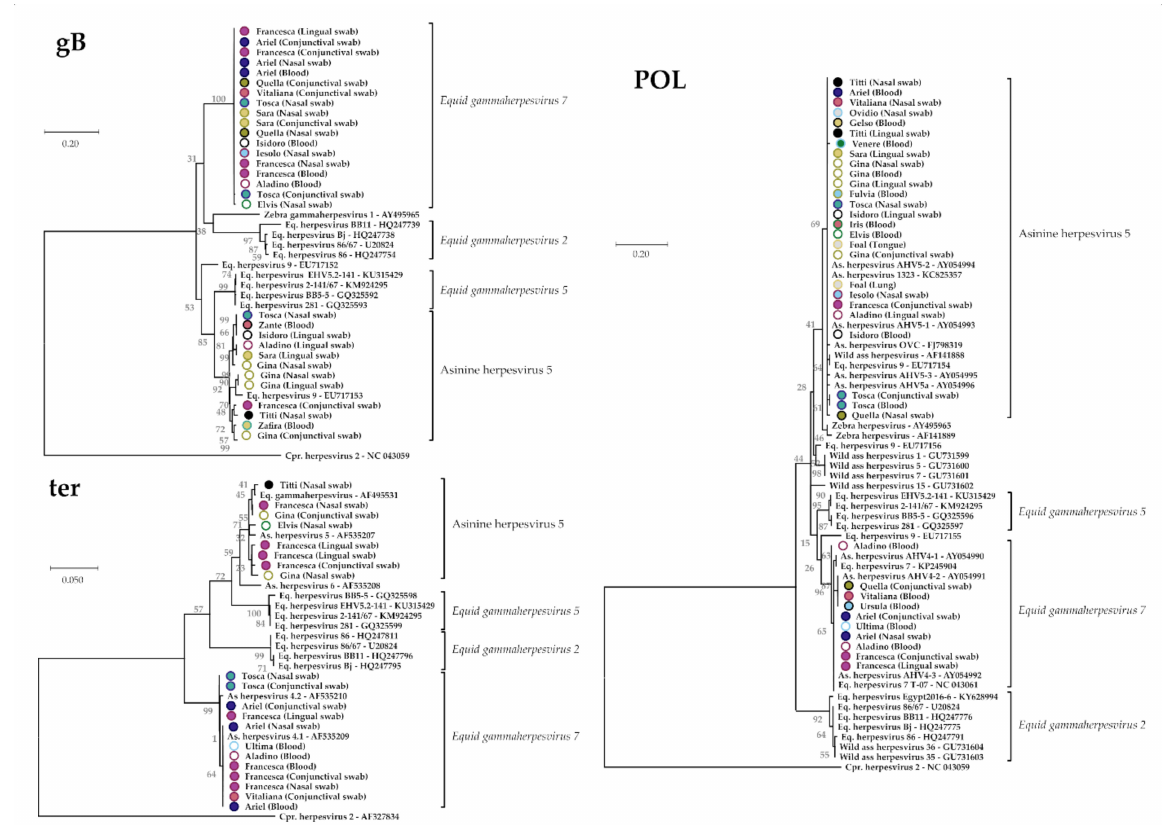
Figure 3. Phylogenetic trees of gammaherpesviruses identified in Pantesco breed donkeys. Maximum likelihood trees based on the glycoprotein B (gB), terminase (ter), and DNA polymerase (DPOL) genes are shown. The trees were built with MEGAX with partial nucleotide sequences (gB: 405nt; ter: 356nt; and DPOL: 182nt) using the maximum likelihood approach with Kimura 2 parameter (gB) or Tamura 3 parameter (DPOL and ter) models, identified as the best fitting models after using the model test analysis implemented in MEGAX. A discrete gamma distribution was used to model evolutionary rate differences among sites (+G = 0.3522 for gB, +G = 0.4073 for DPOL, and +G = 0.8178 for ter) and branch robustness was evaluated through 1000 bootstrap replicates. Official (italics) or provisory species names are indicated when available, and sequences obtained in this study are colour-coded, with each colour representing one donkey whose id. (and type of sample) are